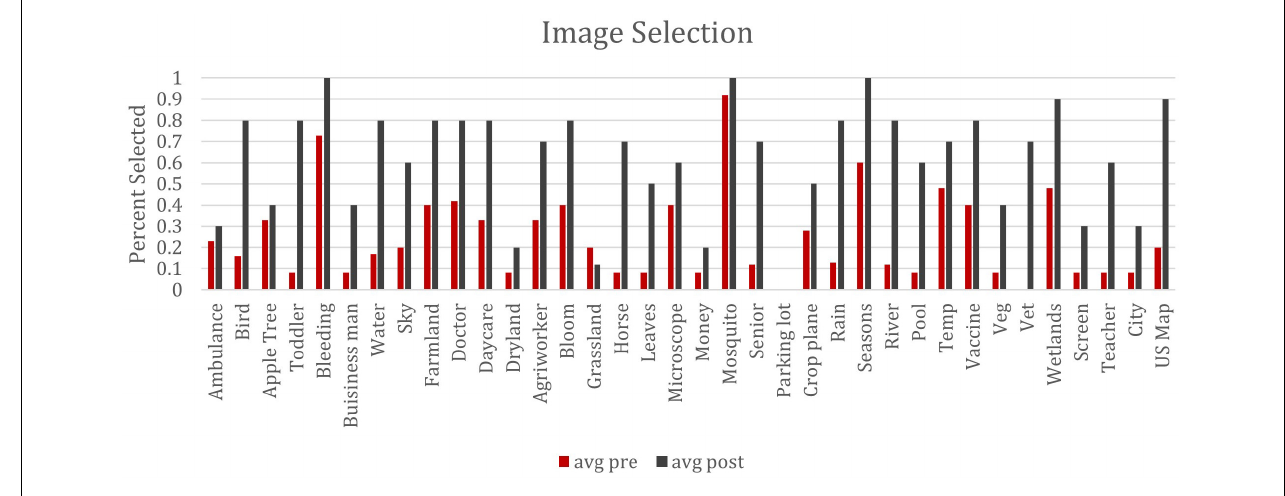
FIGURE 1 | Percentage of images selected pre and